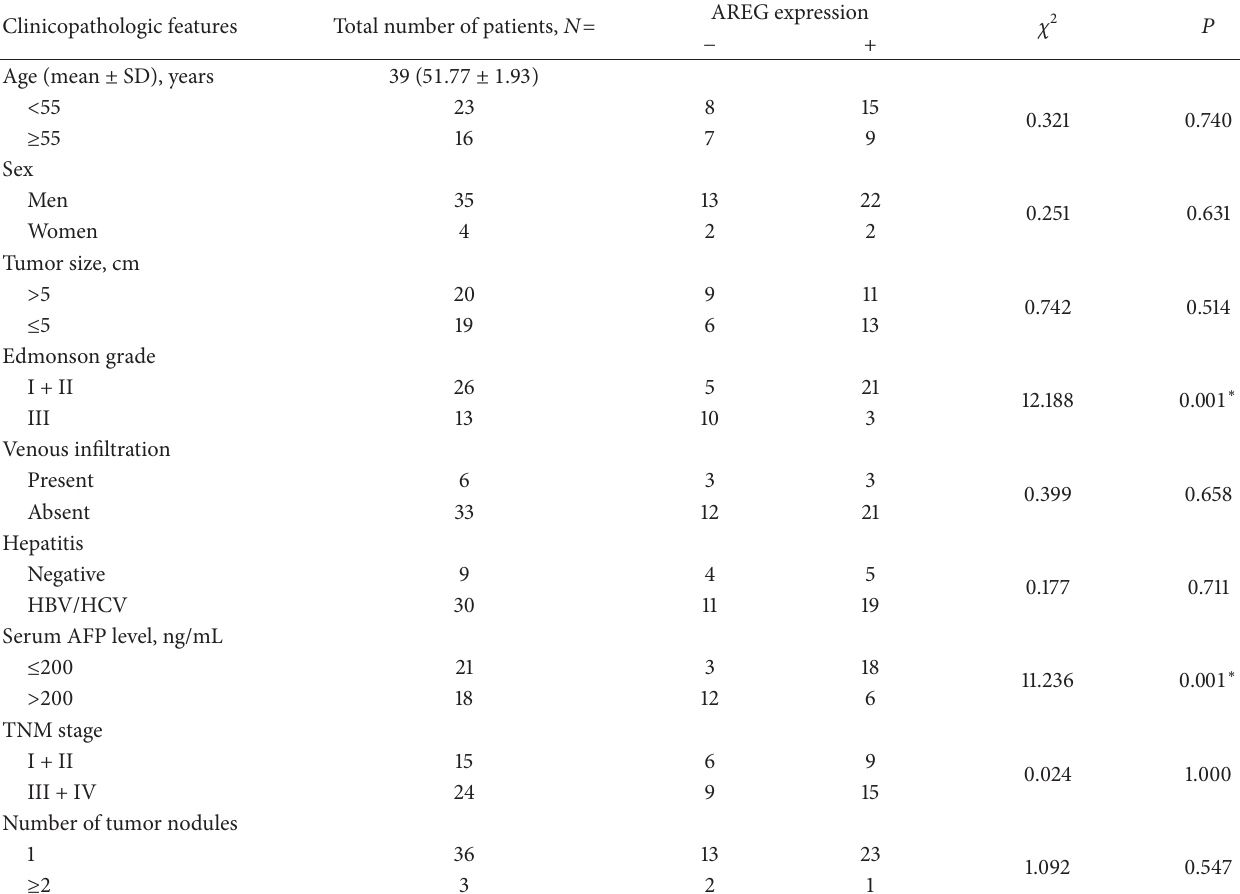
Table 2: Clinical correlation of AREG expression in